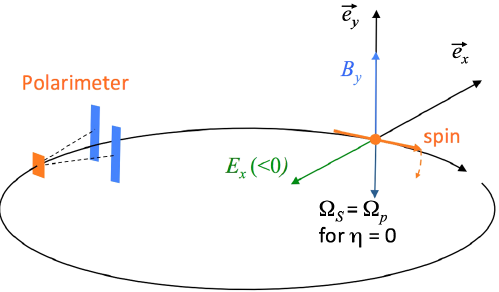
FIG. 2. Principle of a frozen spin EDM ring with a beam rotating clockwise. Note that the magnetic field B upwards and the radial electric field E center as would be the case for a proton frozen spin EDM ring operated below the magic